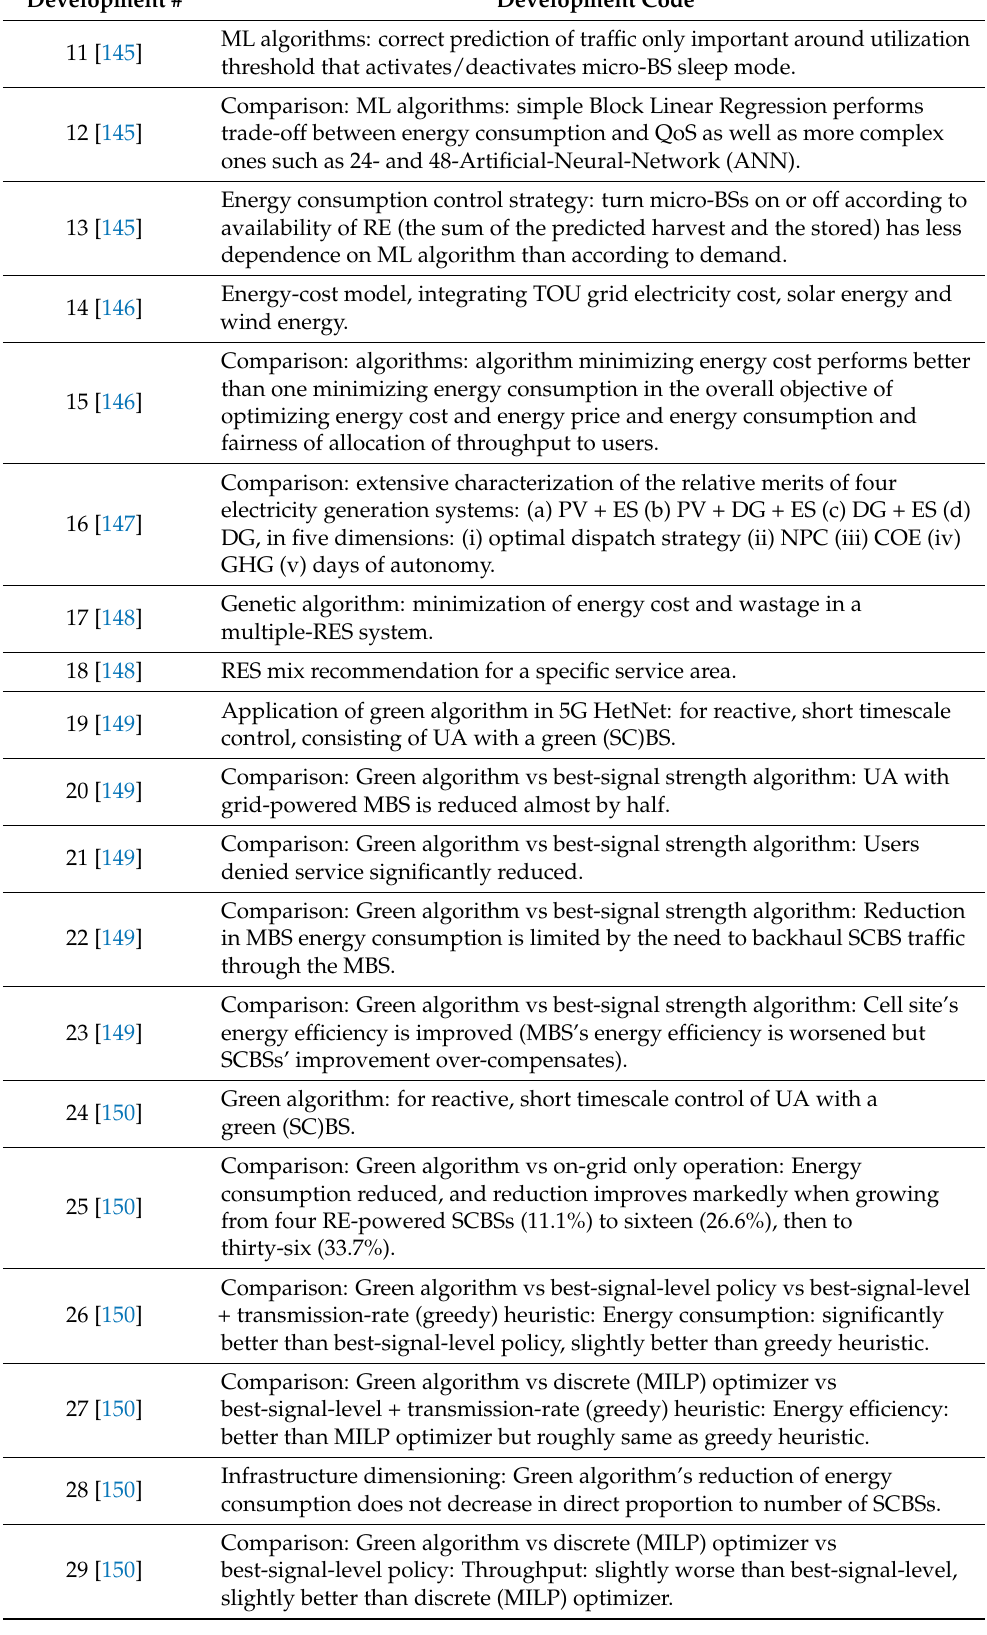
Table A3. Cont. Development # Development